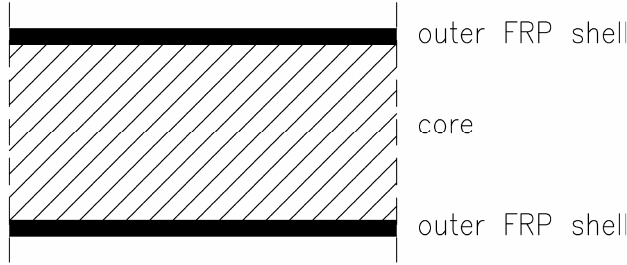
Figure 6. Typical structure of a sandwich panel.